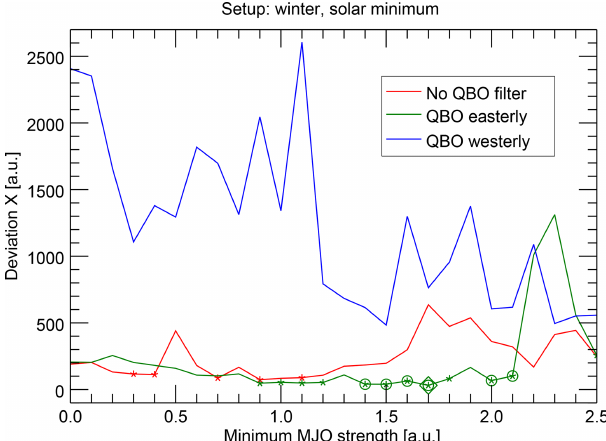
Figure 6. As in Fig. 5, but with results resolved for the QBO phase. The green line corresponds directly to the green line in Fig. 5.